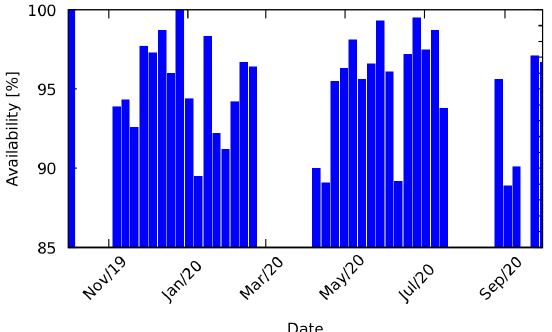
FIG. 4. Weekly neutron beam availability at the SNS during FY20.